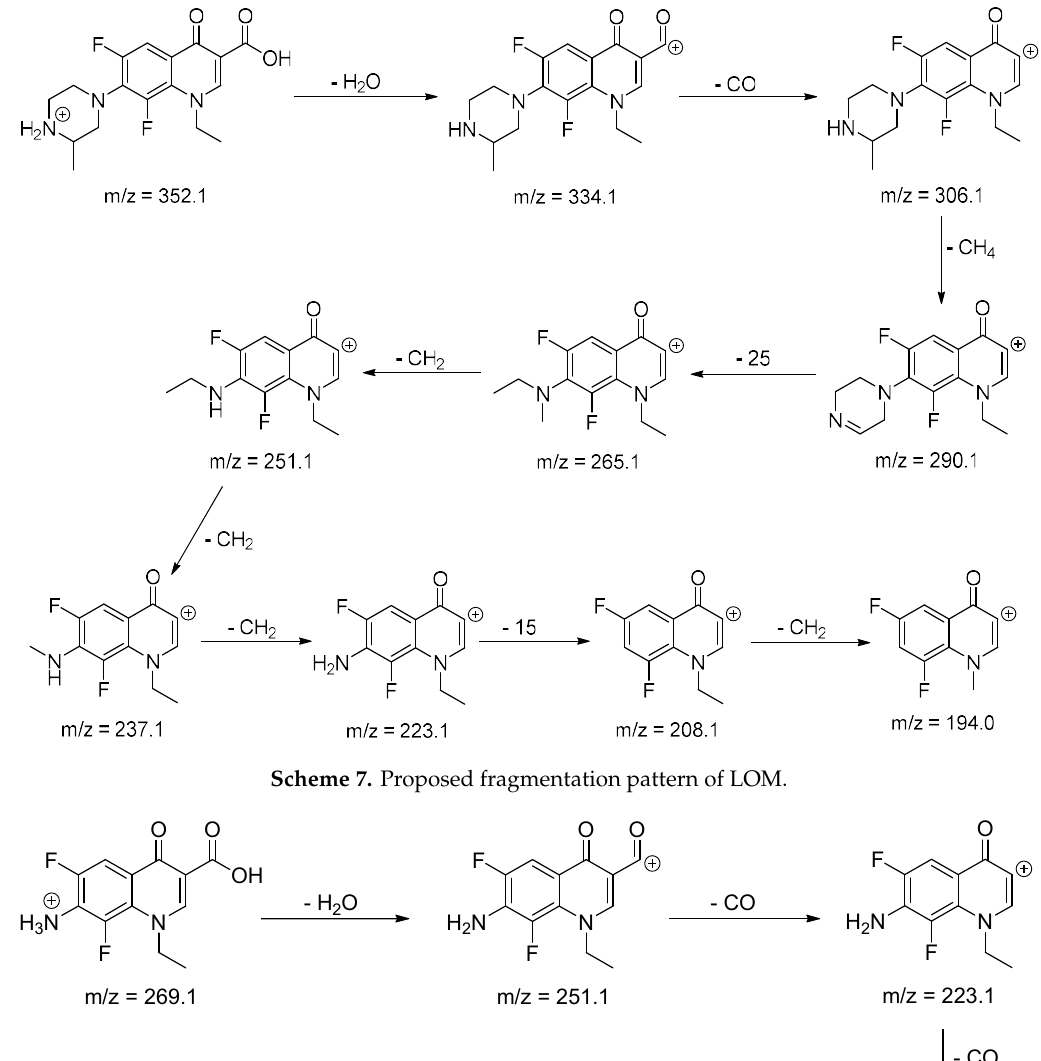
Scheme 7. Proposed fragmentation pattern of LOM.